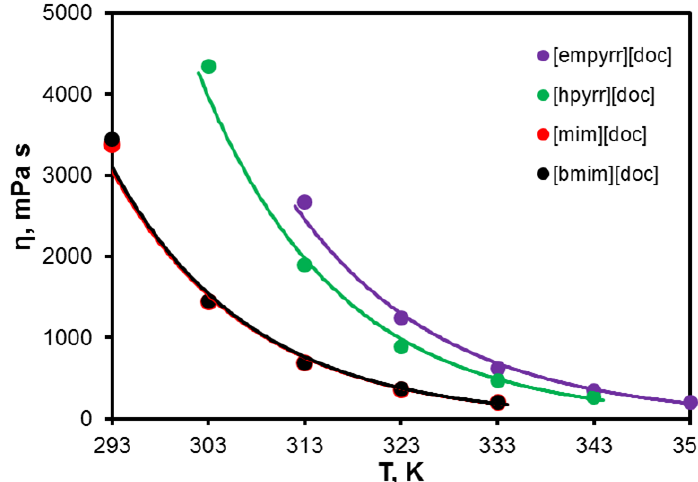
Figure 3. Density of the ionic liquids as a function of temperature.